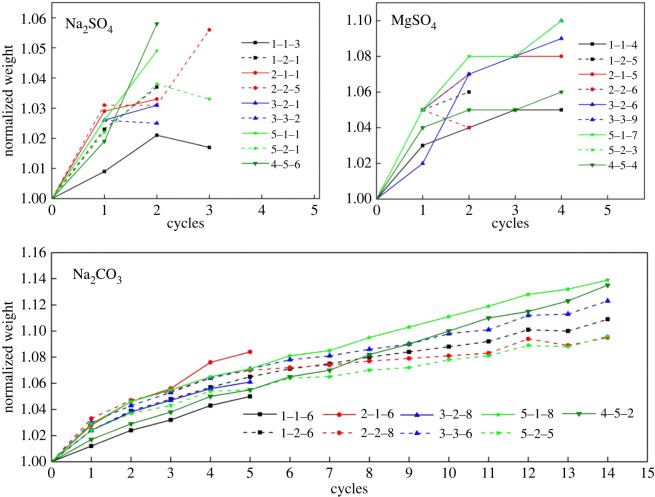
Weight evolution of the compact samples in the dry state when immersed in 14% Na2SO4, MgSO4, and Na2CO3 solutions. For each sample, the normalized weight is calculated as the weight of the sample after cycling divided by the original weight of the sample. The last dot of each line denotes the normalized weight and corresponding cycles of the sample before failure.